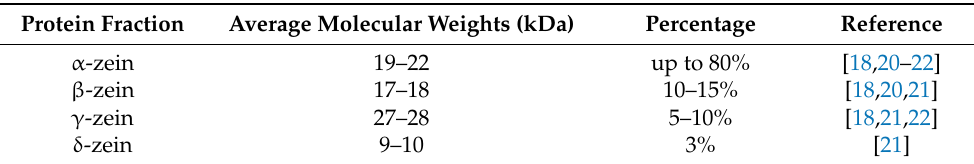
Table 1. The different zein fractions obtained from maize with their average molecular weights and percentages.